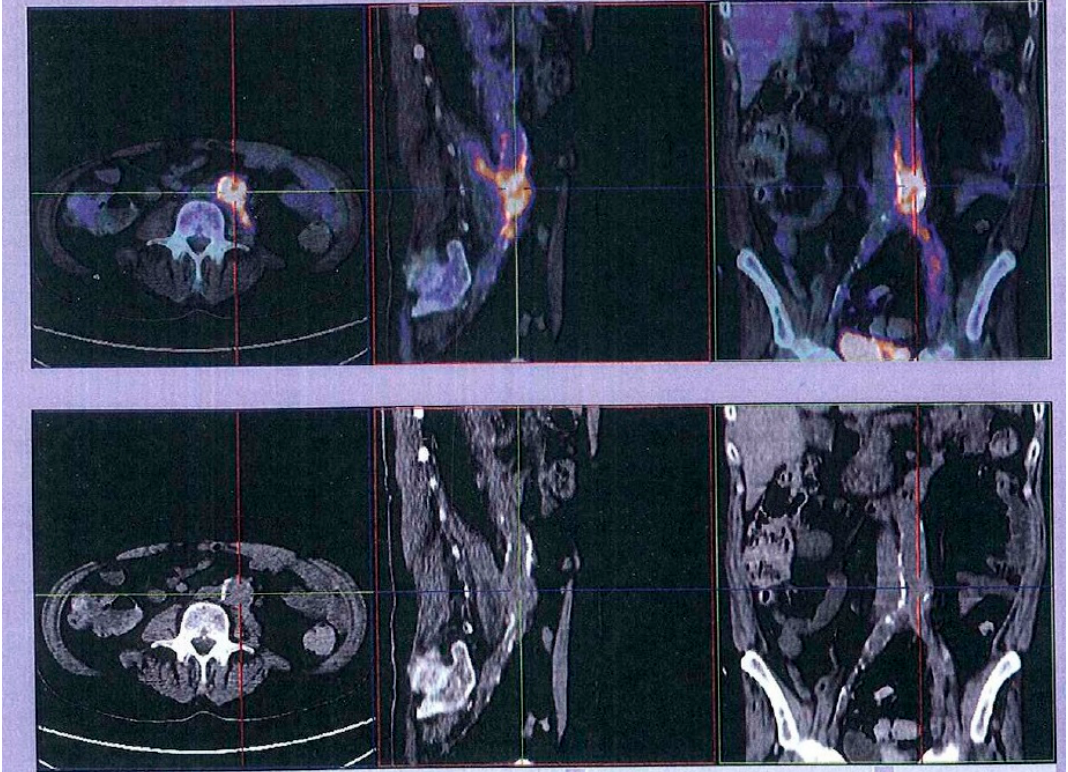
Figure 1. 18F-FDG PET / CT revealing hypercaptation along aortic prosthesis extending into common and left external iliac arteries.